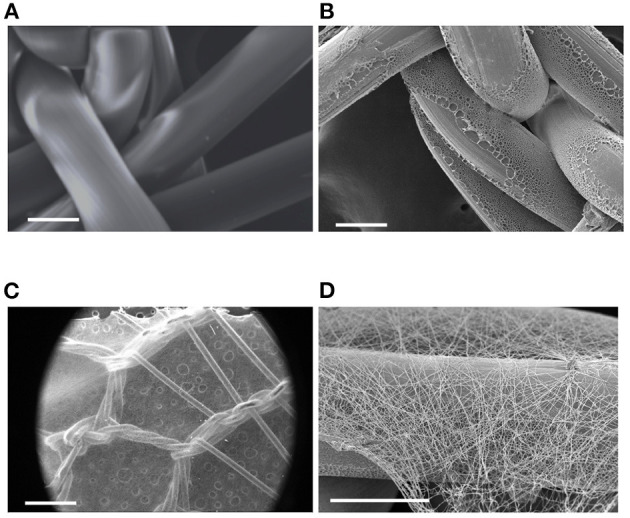
SEM images of: (A) pristine PP mesh, (B) PP mesh coated with PCL film, (C,D) meshPCL-Gel device at different magnifications. Scale bars equal to 100 μm (A,B,D), and 1 mm (C).